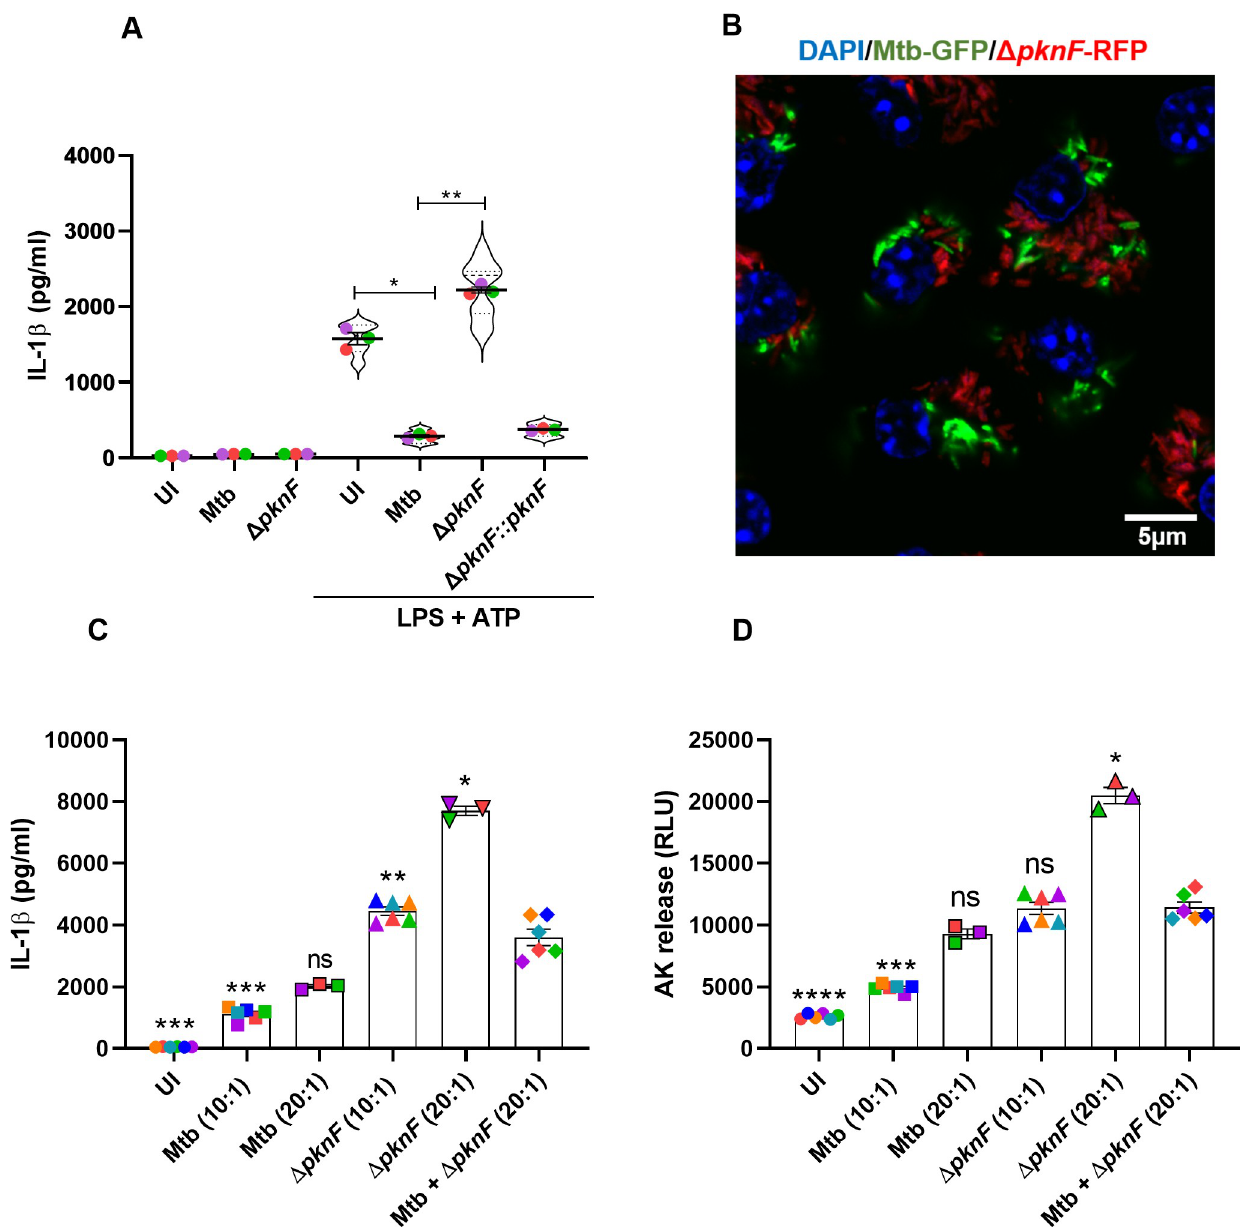
Fig 3. The Mtb-mediated inhibition of the NLRP3 inflammasome activation in BMDMs is dependent upon PknF. BMDMs were either left unprimed or primed with LPS (100ng/ml, 4 h), concomitantly infected where needed with different Mtb (CDC1551) strains (Mtb, Δ pknF mutant and complement Δ pknF :: pknF ), prior to treatment with ATP (0.1mM, 30 min) to activate the NLRP3 inflammasome. Unprimed/uninfected (UI) cells, Mtb and Δ pknF mutant infection alone served as control in the experiment. LPS-primed UI cells stimulated with ATP were used as positive control. Cell supernatants were harvested after 30 min of stimulation and analyzed for (A) IL-1 β release by ELISA. Data are representative of three independent biological replicates with n = 6 in technical replicates per condition. Each colored data point represents average of technical replicates for each of the biological replicate (n = 3). BMDMs were either left uninfected (UI) or mono-infected at two different MOI (10:1 and 20:1) or co-infected at a MOI of 10:1 for each strain for 4 h with Mtb- gfp and Δ pknF-rfp mutant CDC1551 strains. After 4 h infection, Co-infected cells were observed by (B) fluorescence microscopy. Scale bar 5 μ m. The cell culture supernatants were harvested at 20 hpi and analyzed for (C) IL-1 β levels and (D) cell death by ELISA and AK release assay respectively. Data are representative of six independent biological replicates. Error bars represent mean ± SEM; � , p < 0.05, �� , p < 0.01 ��� , p < 0.001, ���� , p < 0.0001, ns (non-